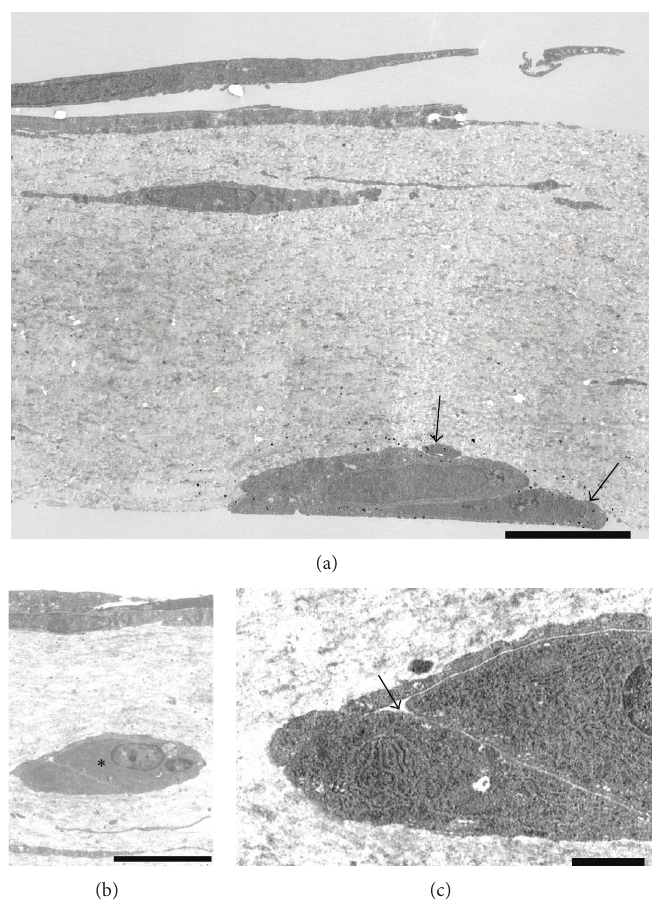
Figure 7: Immunoelectron microscopy of CD133. (a) At the bottom side of the collagen gels, CD133-positive cells made contact with each other (arrows). Cell organelles were sparse in the cells. Scale bar = 5 𝜇 m. (b) CD133-negative cells made contact with each other in the middle layer of the collagen gels ( ∗ ). Scale bar = 5 𝜇 m. (c) Enlargement of (b) ( ∗ ). These cells formed intercellular vacuolar structures (arrow). Cell organelles, such as the rough endoplasmic reticulum, were rich in these cells. Scale bar = 1 𝜇